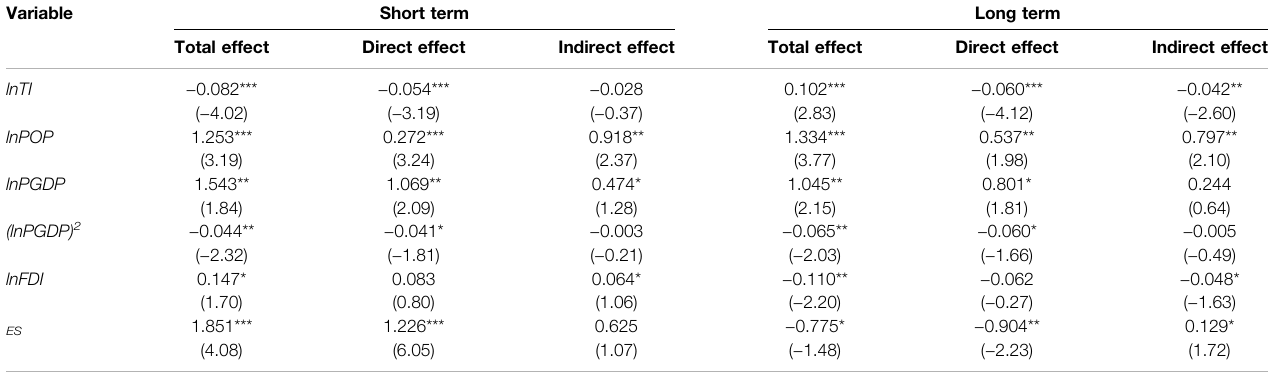
TABLE 6 | Decomposition effects of low-carbon tech-innovation on haze pollution (W 2 ).